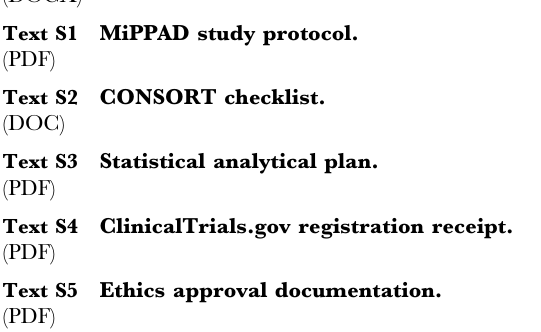
Figure S1 Trial profile (ATP cohort). (TIF) Figure S2 Time to first episode of clinical malaria. (TIF) Figure S3 Adherence to cotrimoxazole prophylaxis by country and treatment group. (TIF) Figure S4 HIV viral load by country. (TIF) Table S1 List of regulatory authorities and national ethical review boards. Table S2 Characteristics of study sites. Table S3 Adverse events by treatment group and cotrimoxazole adherence. Table S4 Placental histology results by treatment